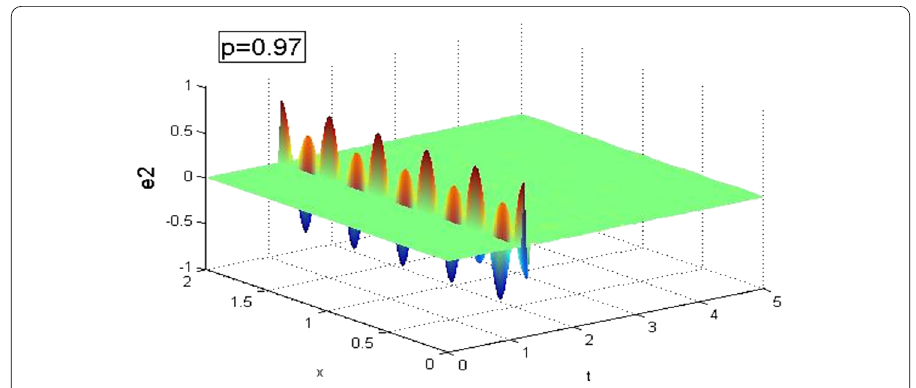
Figure 6 Time evolution of the linear synchronization control error e